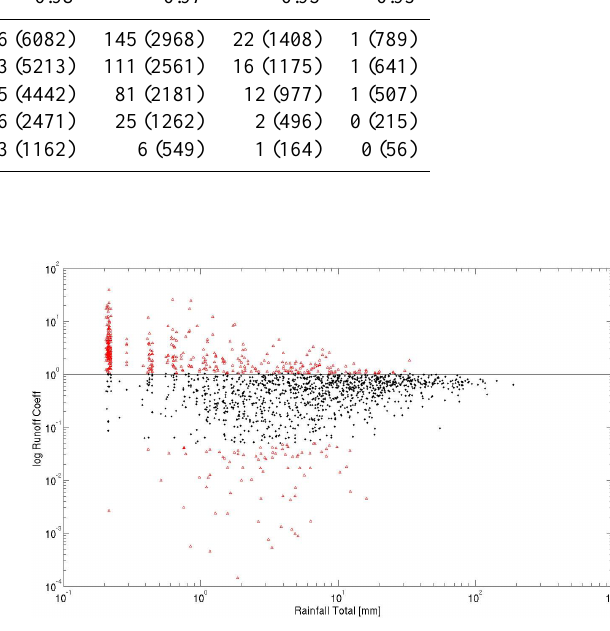
Fig. 4. Scatter plot of runoff coefficient against total rainfall for the 1817 events identified in the time period. Those in red are consid- ered as